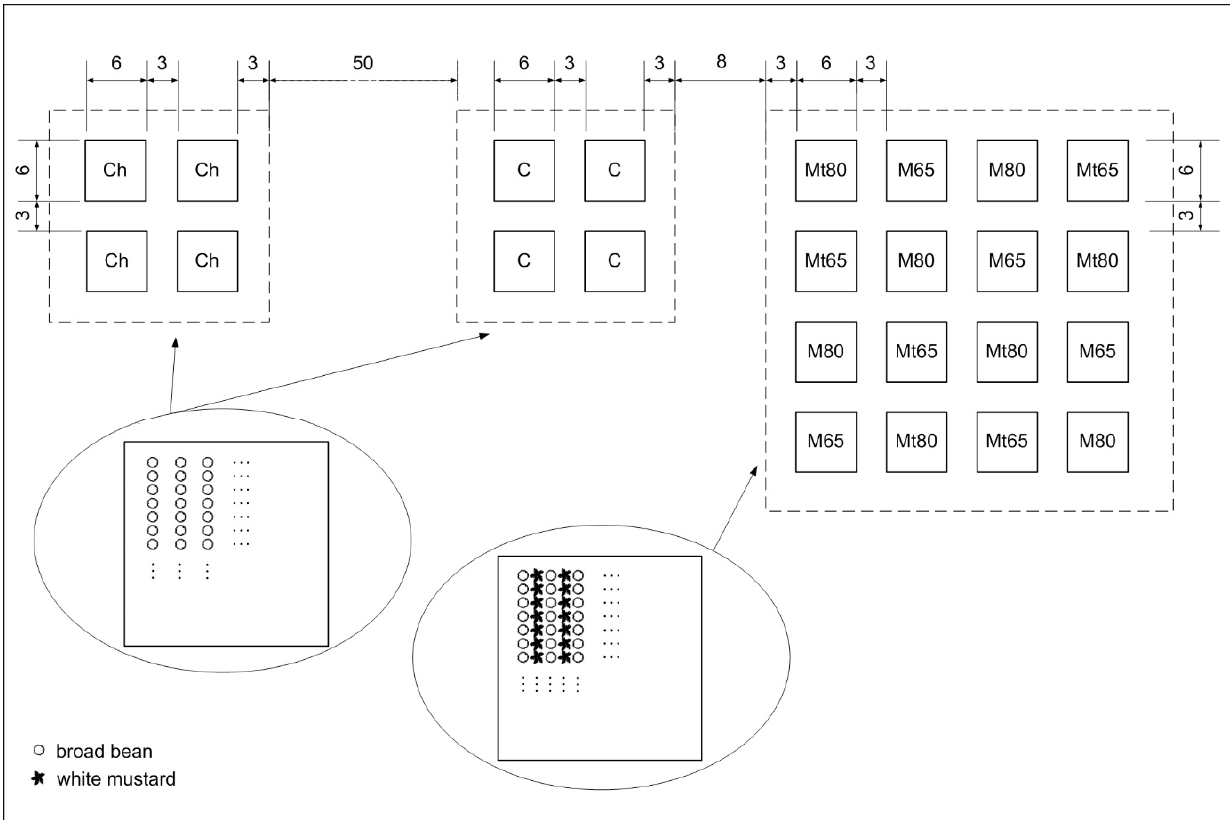
Figure 1. Experiment scheme. Ch—broad beans in homogeneous cultivation with 50 ‐ cm row spacing subjected to standard chemical pest control practice; Control—broad beans in homogeneous cultivation with 50 ‐ cm row spacing; M65—broad beans with mustard with 65 ‐ cm row spacing, not thinned; M80—broad beans with mustard with 80 ‐ cm row spacing, not thinned; Mt65—broad beans with mustard with 65 ‐ cm row spacing, thinned; Mt80—broad beans with mustard with 80 ‐ cm row spacing, thinned. In Ch and Control were: 13 rows of broad bean per plot, 40 plants of broad bean in each row; in M65 and Mt65: 10 rows of broad bean per plot, 40 plants of broad bean in each row, 9 rows of mustard, 240 plants of mustard in each row (before thinning in Mt65); in M80 and Mt80: 8 rows of broad bean, 40 plants of broad bean in each row, 7 rows of mustard, 240 plants of mustard in each row (before thinning in Mt80).